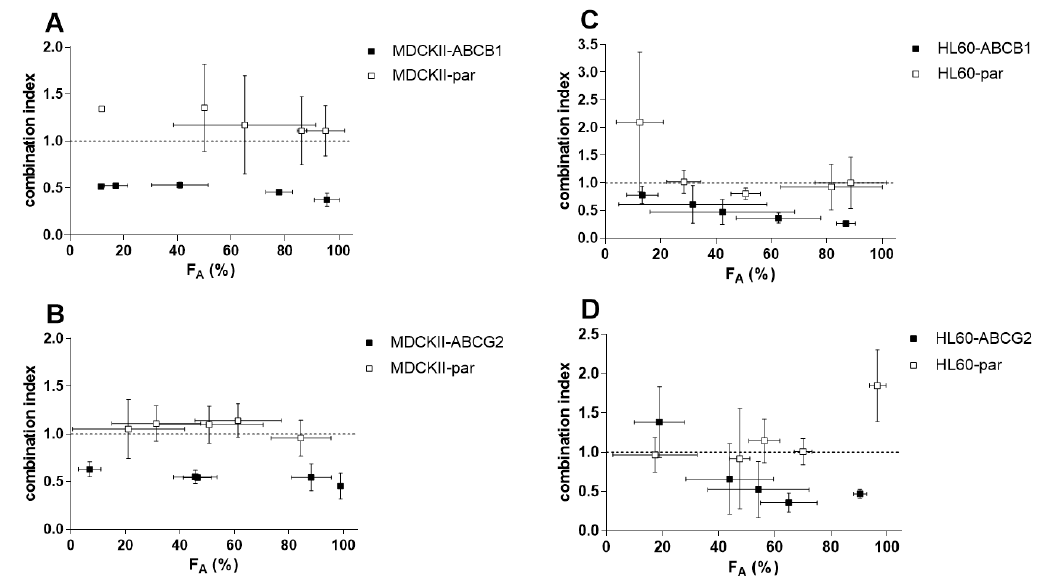
Figure 7. F A -combination index (CI) plot for the combinations of 10 µM ensartinib with daunorubicin or mitoxantrone in MDCKII-ABCB1/HL60-ABCB1 ( A , C ) and MDCKII-ABCG2/HL60-ABCG2 ( B , D ) cells, respectively. The results obtained with the same combinations in the parental cell lines are also shown. F A -CI plots were generated by using CompuSyn software to analyze the combination data shown in Figure 6 and ensartinib proliferation data (not shown). Combination outcomes can be synergistic (CI < 0.9), additive (0.9 < CI < 1.1), or antagonistic (CI > 1.1). The plotted data points are means ± SD from at least three independent experiments.